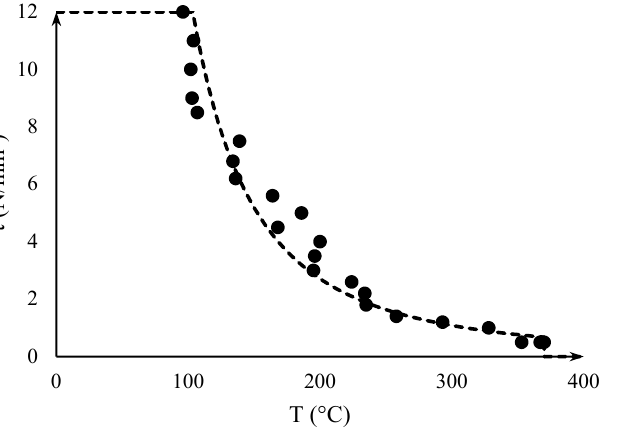
Figure 8. Bond stress vs. temperature relationship for Adhesive-1 according to EAD 330087-00-0601 [15].